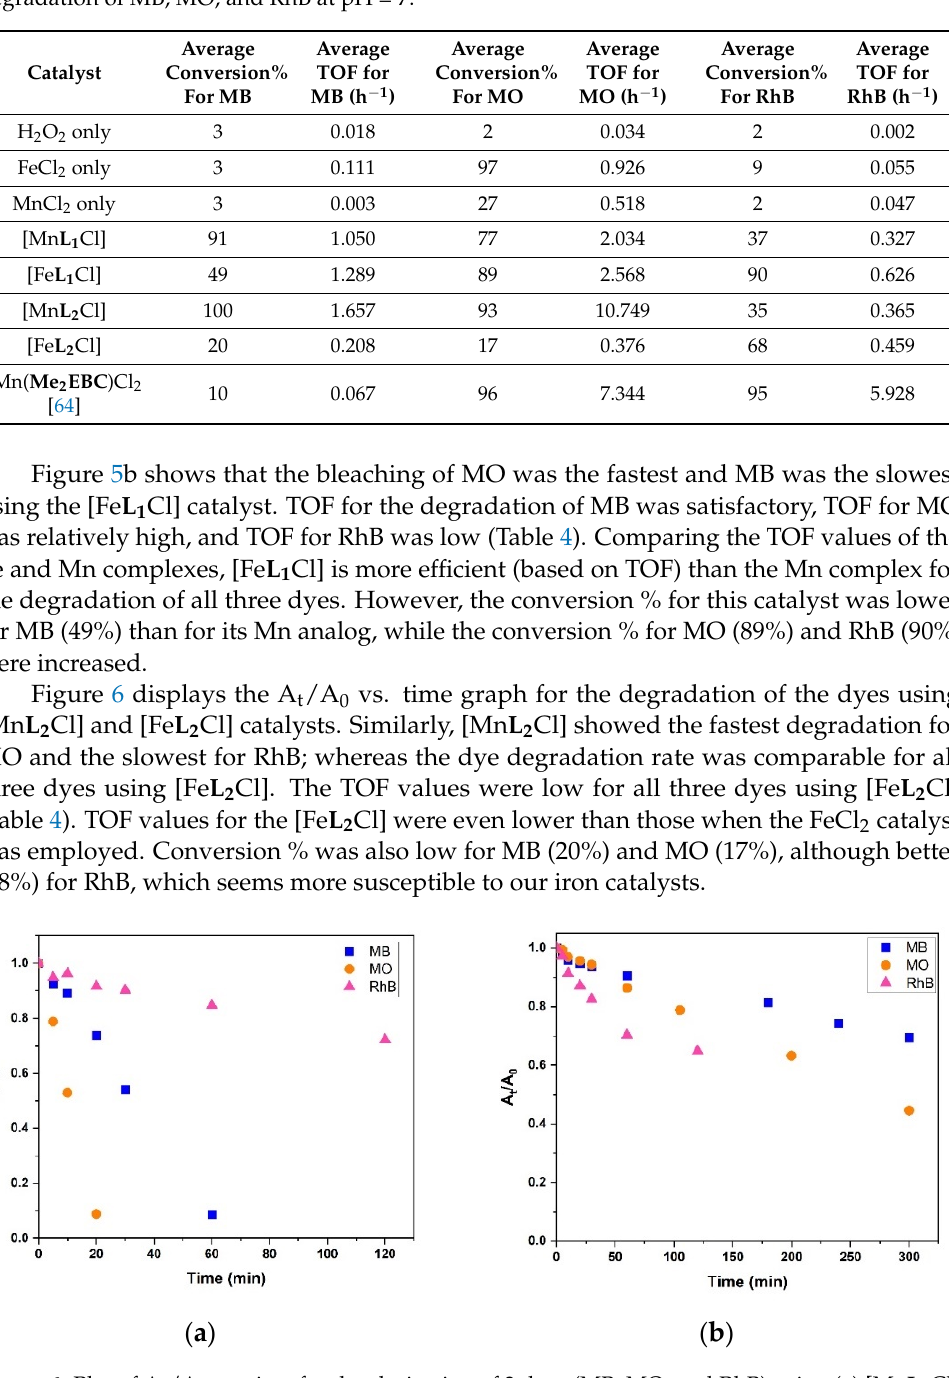
Figure 6. Plot of A t /A 0 vs. time for decolorization of 3 dyes (MB, MO, and RhB) using ( a ) [Mn L 2 Cl] and ( b ) [Fe L 2 Cl] as catalysts. [Note: The time = 0 initial points for all three dyes are congruent, as the time = 0 point is defined as 1.0 in the ratio A t /A 0 for all three dyes. Individual plots of each dye are available in the supplementary